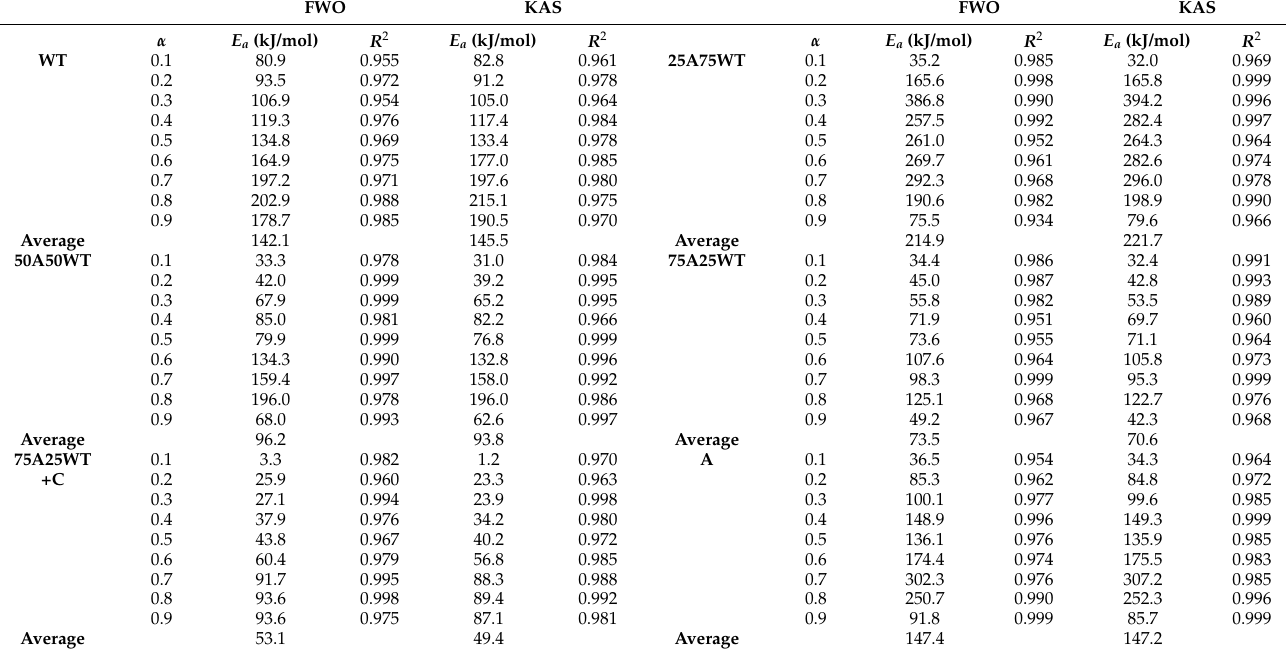
Table 3. Kinetic parameters obtained by FWO and KAS approaches at different conversion